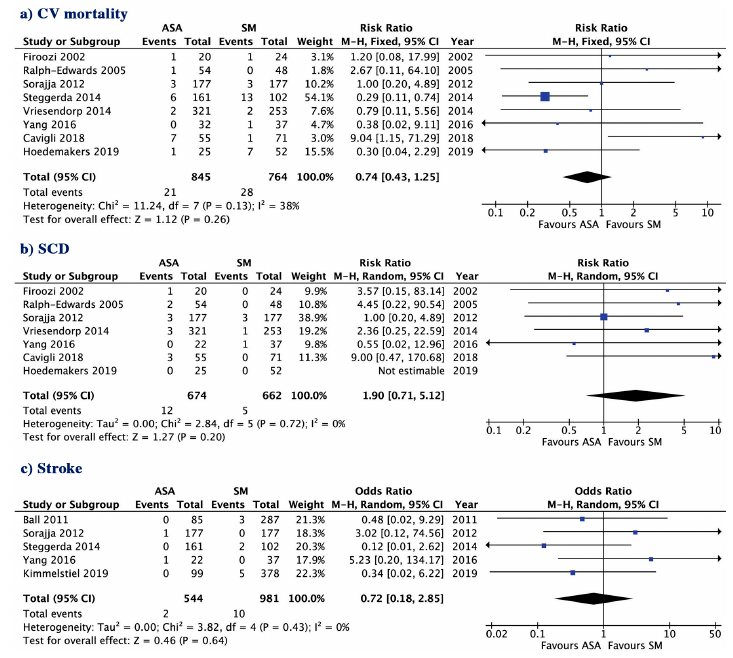
Figure 1. Risk ratio of outcome with alcohol septal ablation (ASA) vs. surgical myectomy (SM); ( a ) Long-term all-cause mortality; ( b ) short-term all-cause mortality. CI, confidence interval.